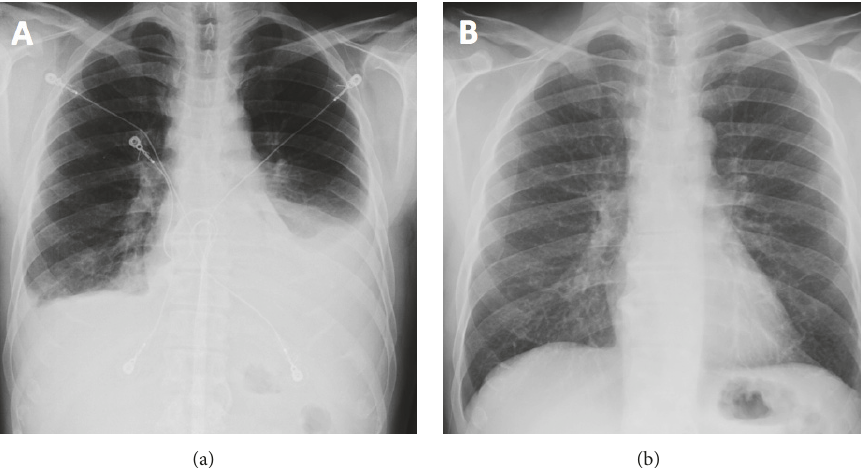
Figure 1: Chest radiograph at admission (a) demonstrates moderate left and trace right pleural effusions with a left retrocardiac opacity. Follow-up chest radiograph shows complete resolution of the abnormalities after treatment (b).